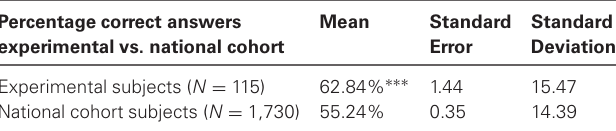
Table 1 | Test percentage correct answers: Spaced Learning vs. course review